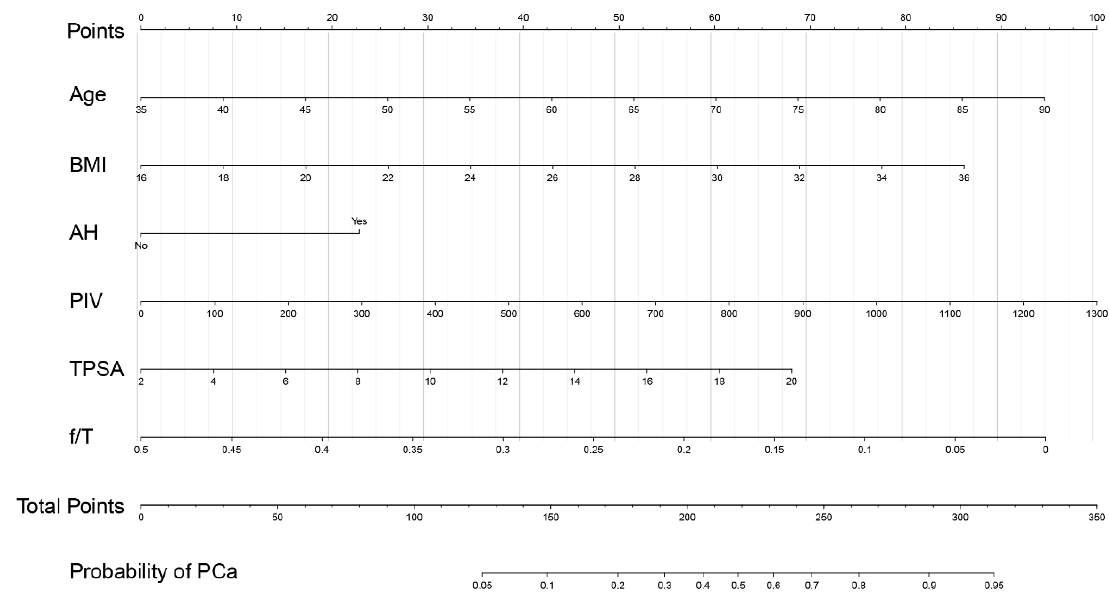
Figure 4. Nomogram for predicting PCa based on the training cohort. The prostate biopsy nomogram was developed in the training cohort, with age, BMI, AH, PIV, TPSA, and f/T incorporated. BMI: body mass index; AH: alcohol history; PIV: pan-immune-inflammation value; TPSA: total prostatic specific antigen; f/T: free/total prostatic specific antigen ratio.